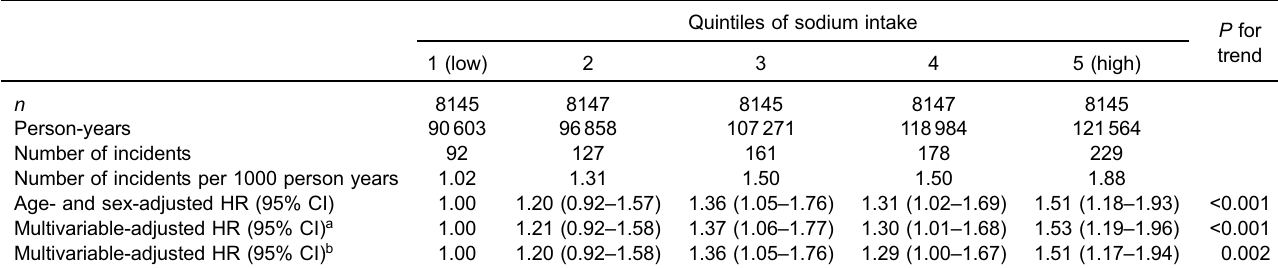
CI, con fi dence interval; HR, hazard ratio. a Adjusted further for body mass index (kg/m 2 ), ethanol intake (current drinker or not and missing), smoking status (four categories), family history of gastric cancer, walking time ( fi ve categories), educational status ( fi ve categories), and perceived mental stress (four categories). b Adjusted further for frequency of total vegetable intake (sex-speci fi c quintiles and missing) and fruit intake (sex-speci fi c quintiles and missing). Table 6. Associations between sex-speci fi c quintiles of sodium intake and risk of gastric cancer Quintiles of sodium